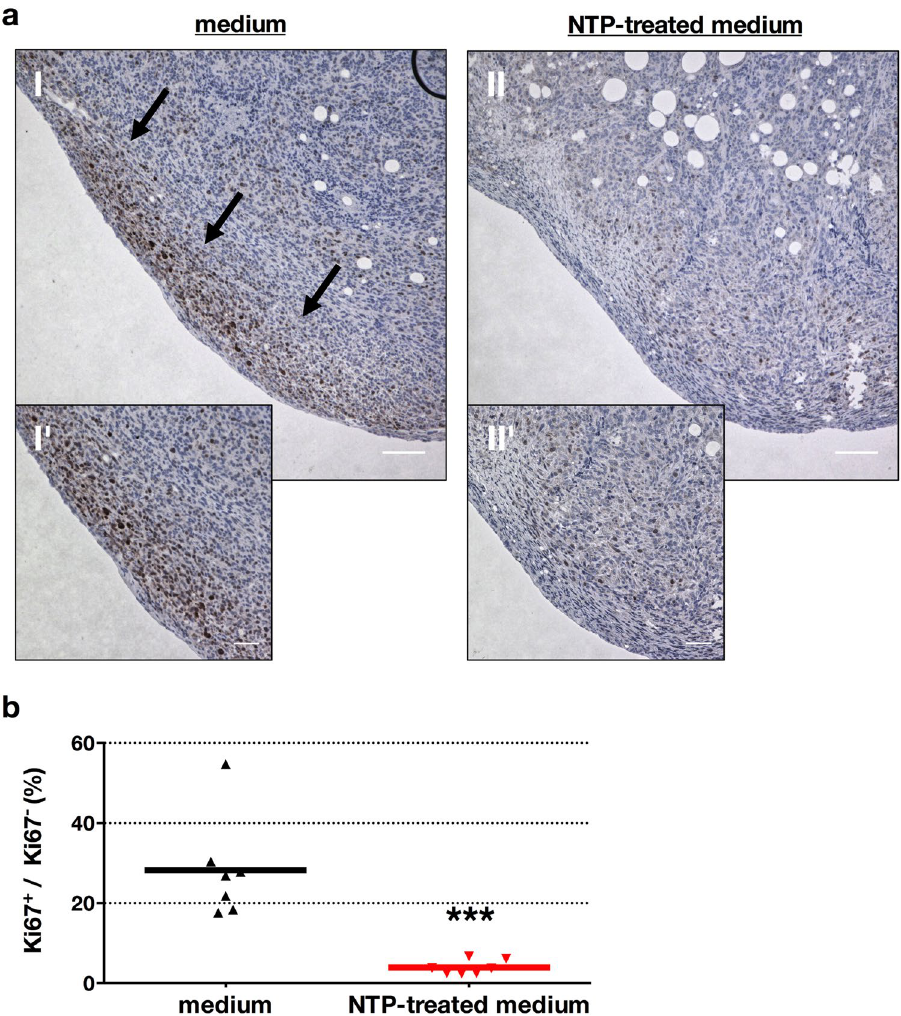
Figure 5. NTP-treated medium abrogated cancer cell proliferation in vivo . Tumor-bearing mice were sacrificed after receiving untreated or NTP-treated medium for 21 consecutive days. Tissue sections of tumors were stained for the proliferation marker Ki67. Microscopy revealed proliferation at the tumor margin in the control ( a I, I ′ , arrows) but not the treatment group (II, II ′ ) and the difference was significant ( b ). Representative images ( a ) or mean of at least 5 different tumor nodes per mouse ( b ) are shown. Scale bars represent 100 µ m (I, II) and 50 µ m (I’,